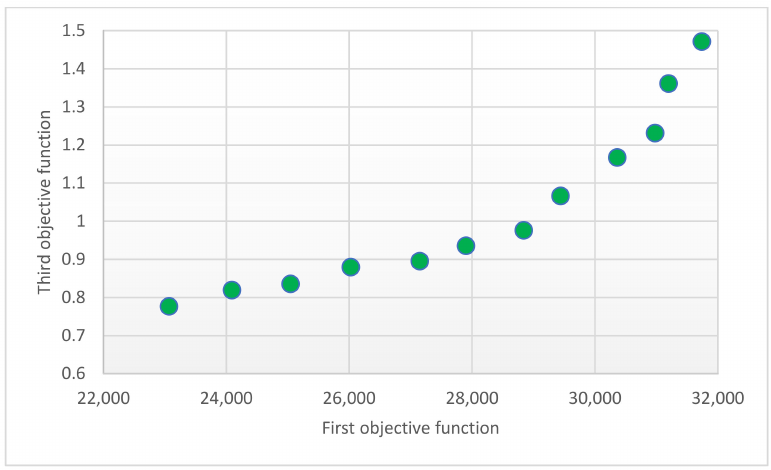
Figure 4. Pareto front of first objective function and third objective function.